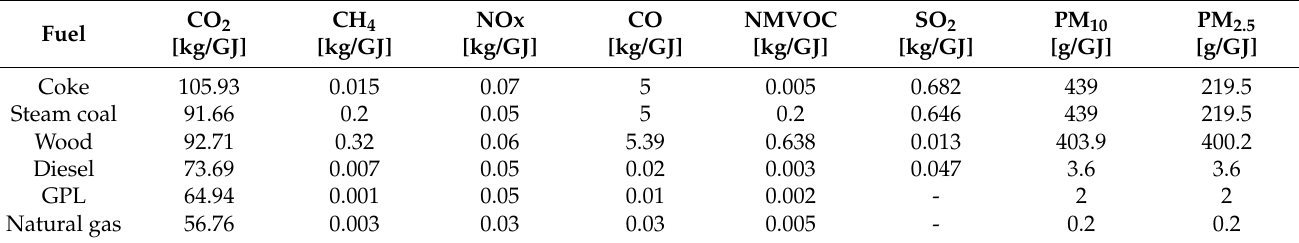
Table 2. Emission factors for domestic